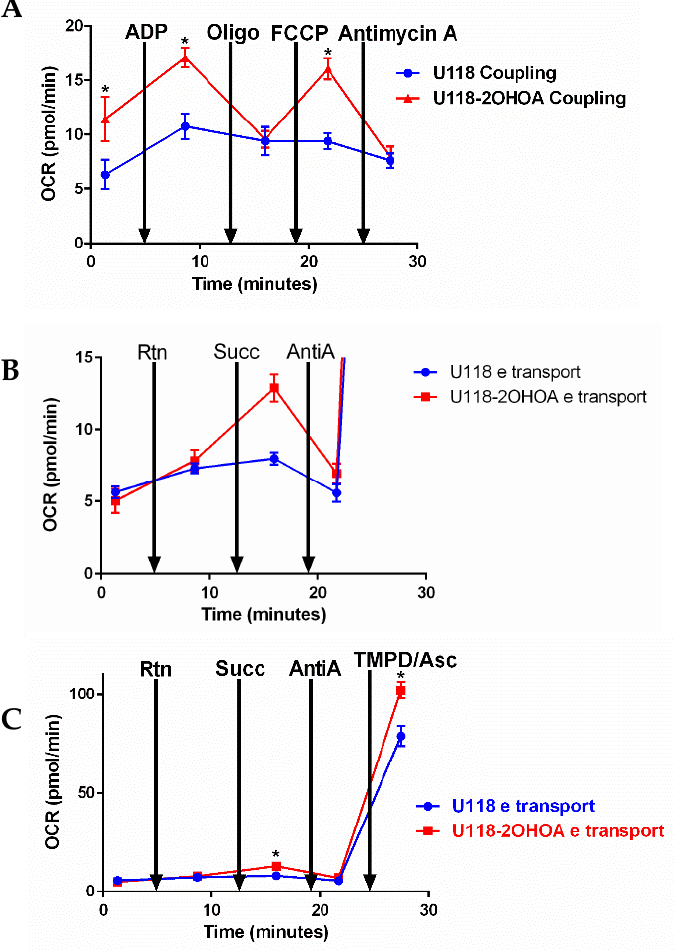
Figure 6. Mitochondria (2 μg/well) were isolated from untreated and 2OHOA-treated (200 μM, 48 h) U118MG cells. Respiratory activities of each complex were analyzed using Agilent’s Seahorse Mito Stress kit according to Agilent’s application note https://www.agilent.com/cs/library/applica- tions/5991-7145EN.pdf. In coupling experiments ( A ), using rotenone and succinate as a substrate, OCR was determined following the addition of indicated reagents. An increase in OCR following ADP and FCCP supplementation indicates a unique uncoupling effect of 2OHOA. ( B ) (blowup of ( C )) Electron flow experiments showing OCR following the supplementation of the indicated inhib-